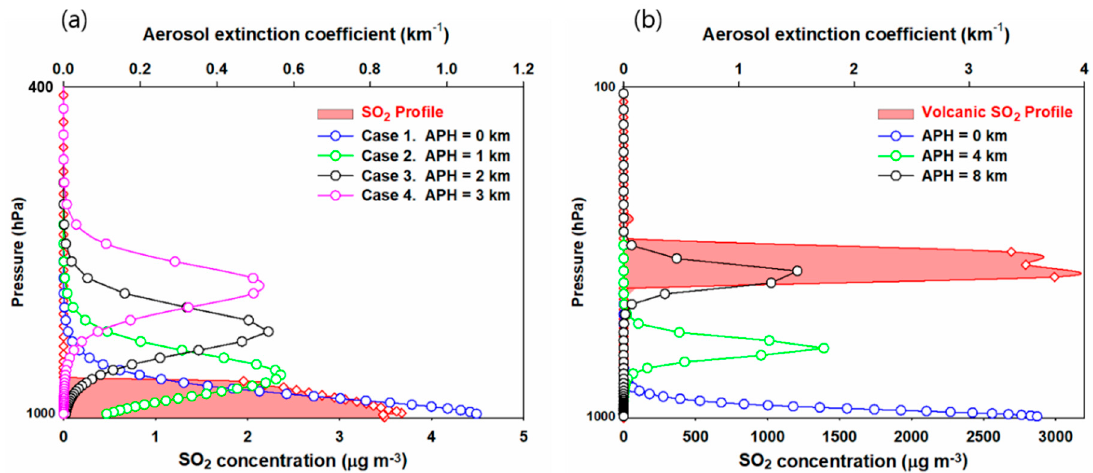
Figure 3. SO 2 and aerosol vertical distributions used for the ( a ) planetary boundary layer (PBL) and ( b ) volcanic SO 2 AMF calculations. The half width is 3 km, and the lower and upper limits for the aerosol height are set to surface level and 10 km, respectively.